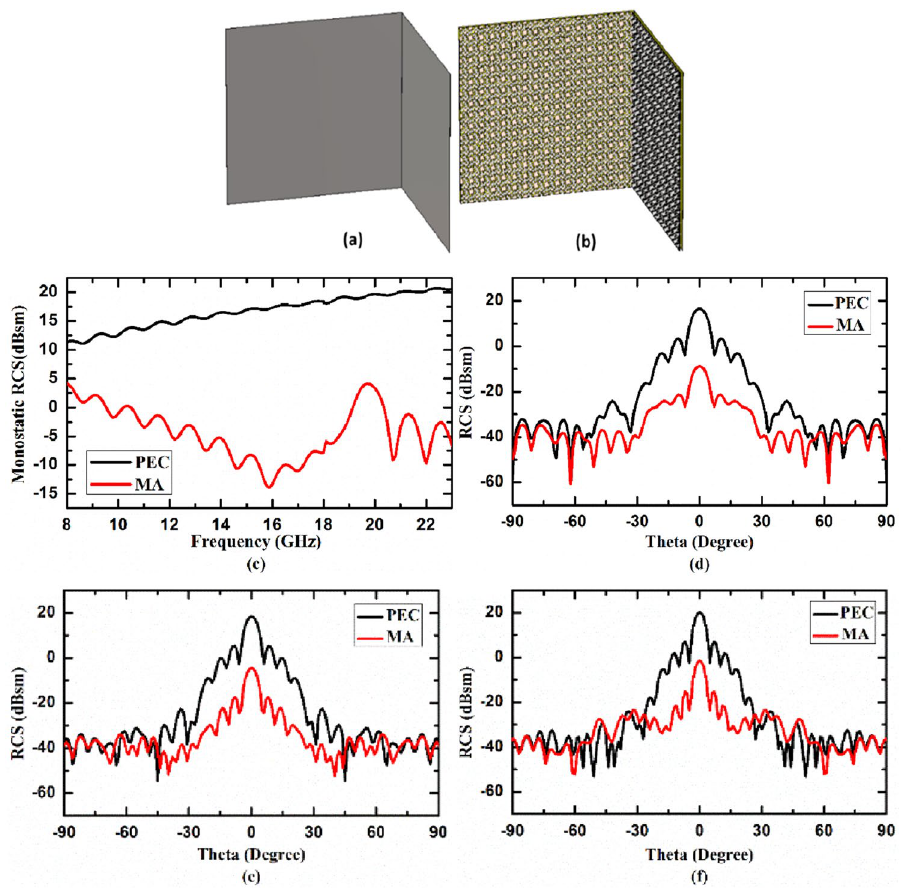
Figure 10. 3D view of 90° dihedral ( a ) PEC and ( b ) MA, ( c ) monostatic RCS, and bistatic RCS at ( d ) 14.84 GHz, ( e ) 17.99 GHz, ( f ) 21.14 GHz under normal